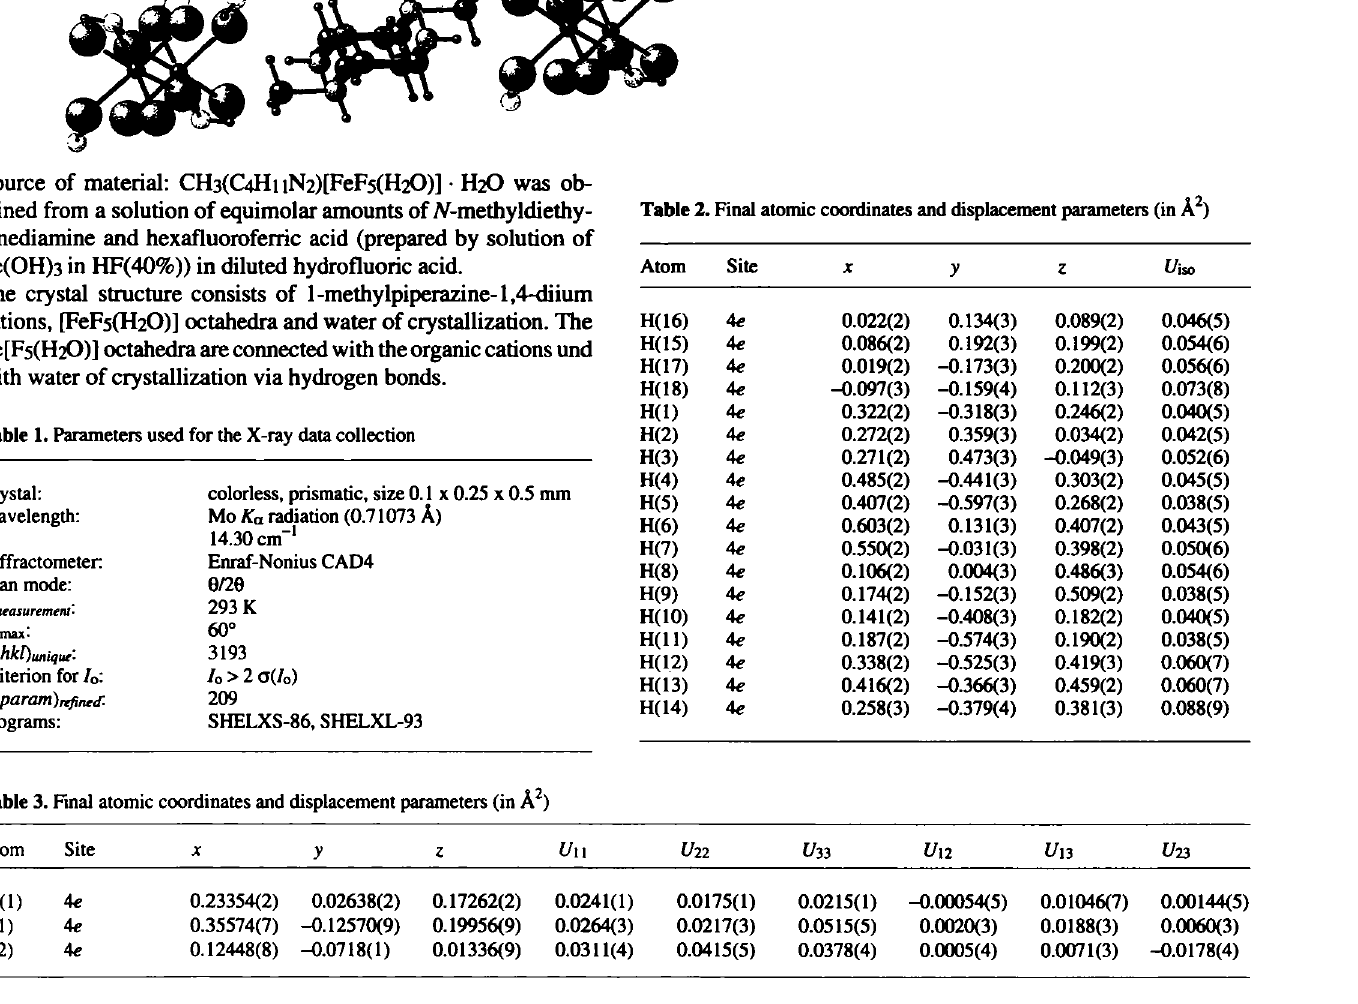
Table 2. Final atomic coordinates and displacement parameters (in Â 2 )